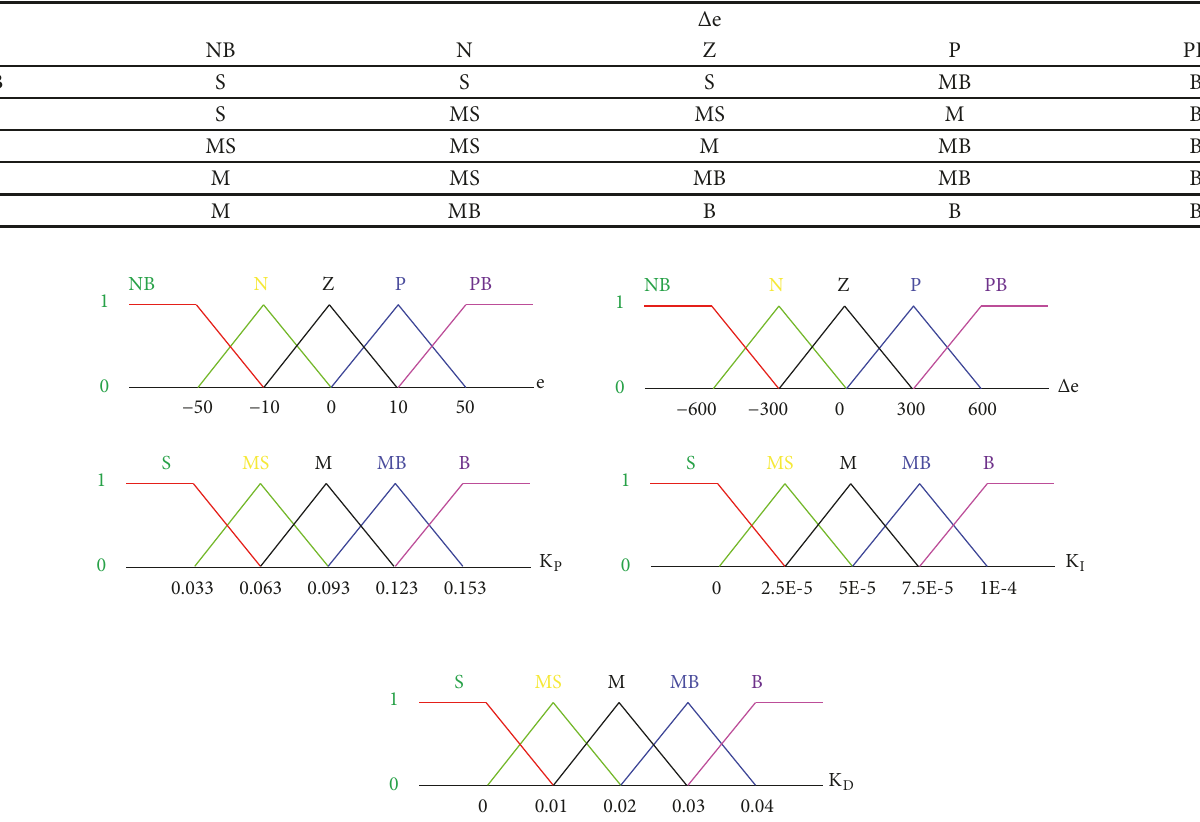
Figure 7: Fuzzy sets of a fuzzy self-tuning PID